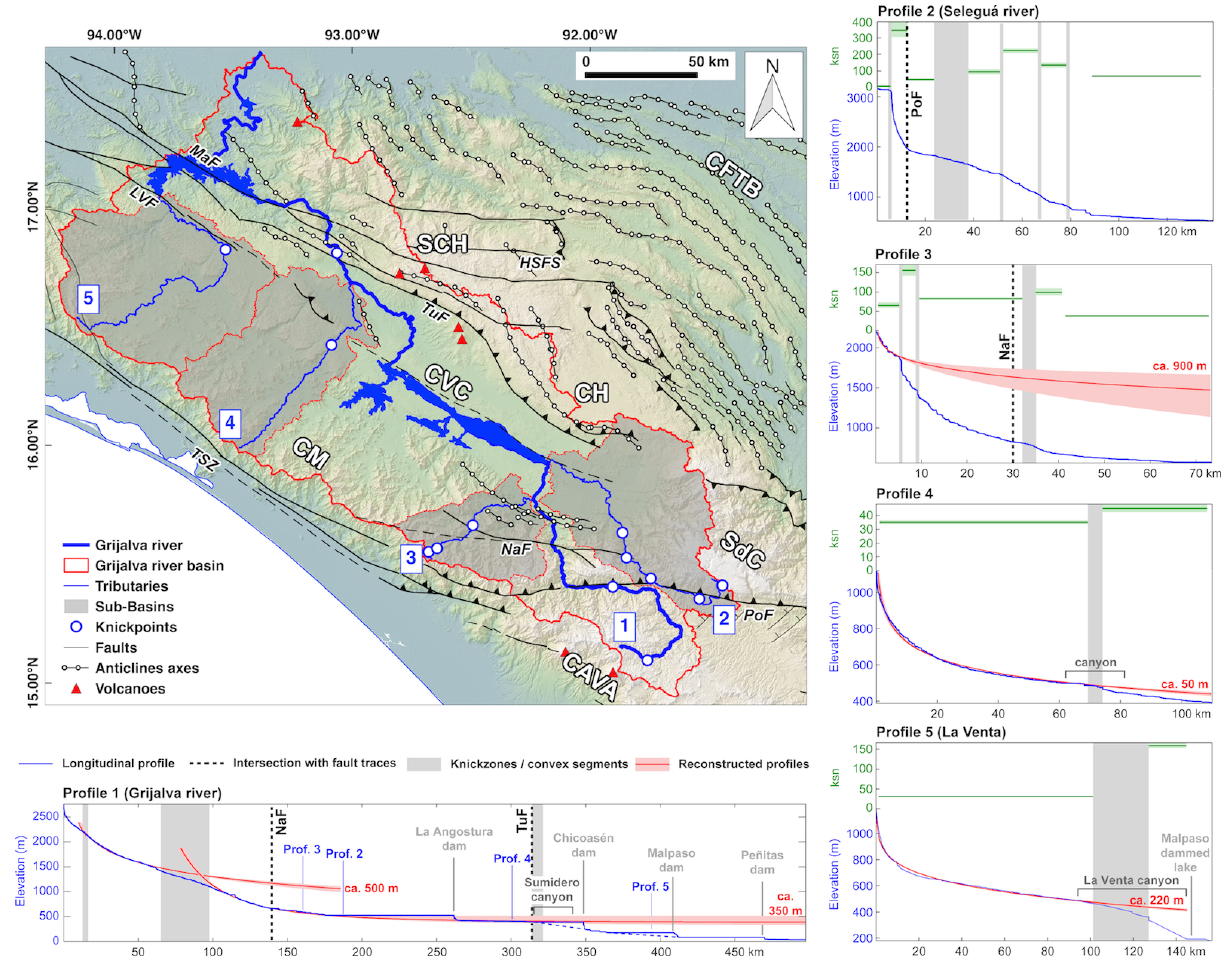
Figure 13. Longitudinal profiles for the Grijalva River and the tributaries from the Sierra de los Cuchumatanes and Chiapas Massif. Profiles were extracted from the modeled drainage network. See Fig. 2 for faults abbreviations and Fig. 12 for plot